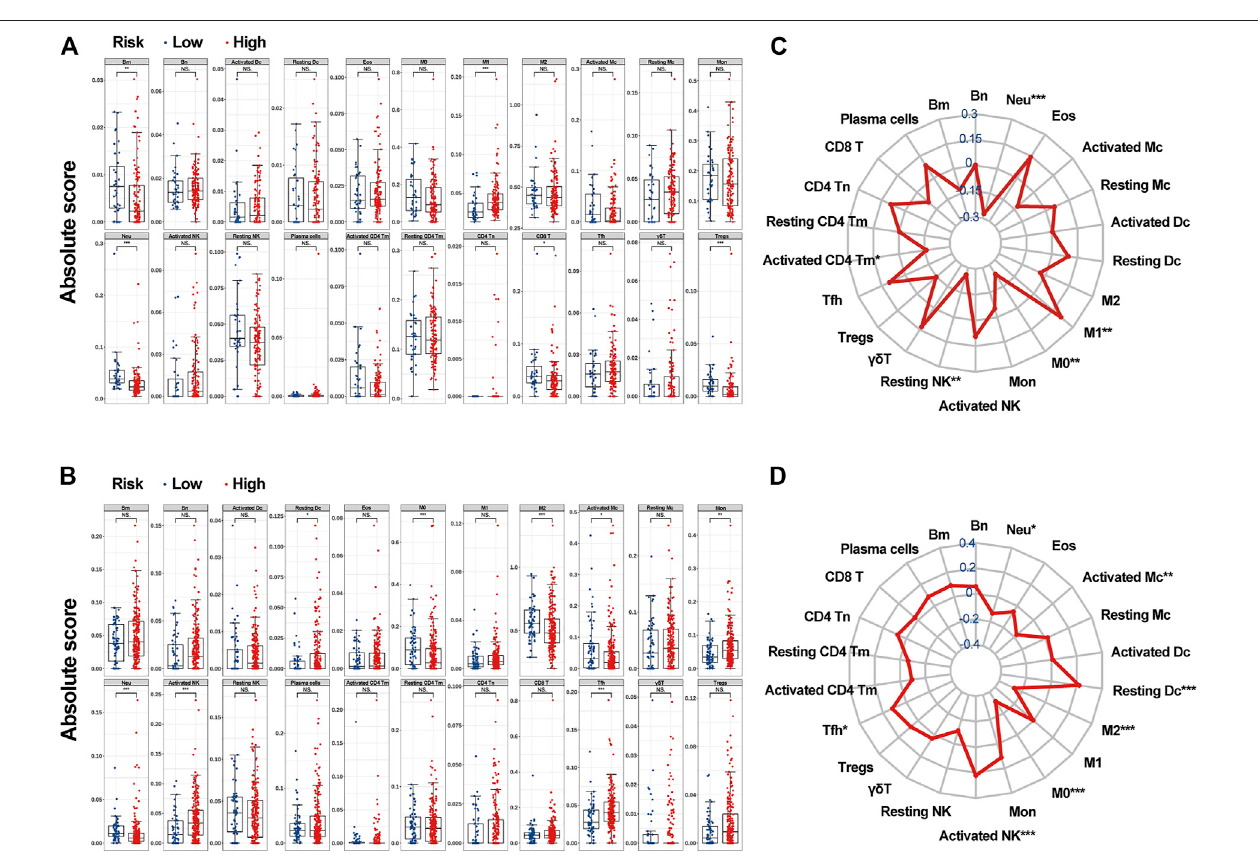
FIGURE 6 | The associations between c_mRNAsi and the abundance of in fi ltrative immune cells. (A) . In fi ltrative immune cell analysis in TCGA. (B) . In fi ltrative immune cell analysis in CGGA. (C) . Radar chart in TCGA. (D) . Radar chart in CGGA. Abbreviations: Bm, memory B cells; Bn, naive B cells; Dc, Dendritic cells; Eos, eosinophils;M0,macrophageM0;M1,macrophageM1;M2,macrophageM2;Mc,mastcells;Mon,monocytes;Neu,neutrophils;Tm,memoryTcells;Tn,naïveTcells; Tfh, follicular helper T cells; γ δ T, gamma delta T cells; Treg, regulatory T